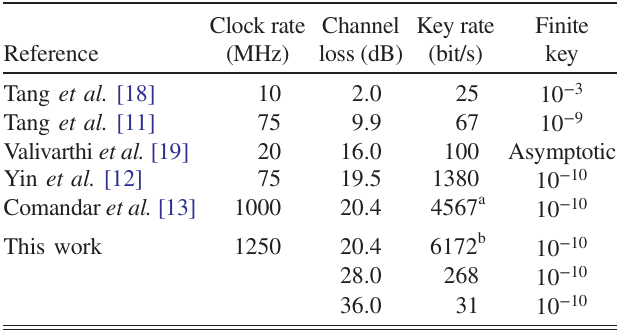
TABLE I. Comparison of state-of-the-art MDI QKD experiments.